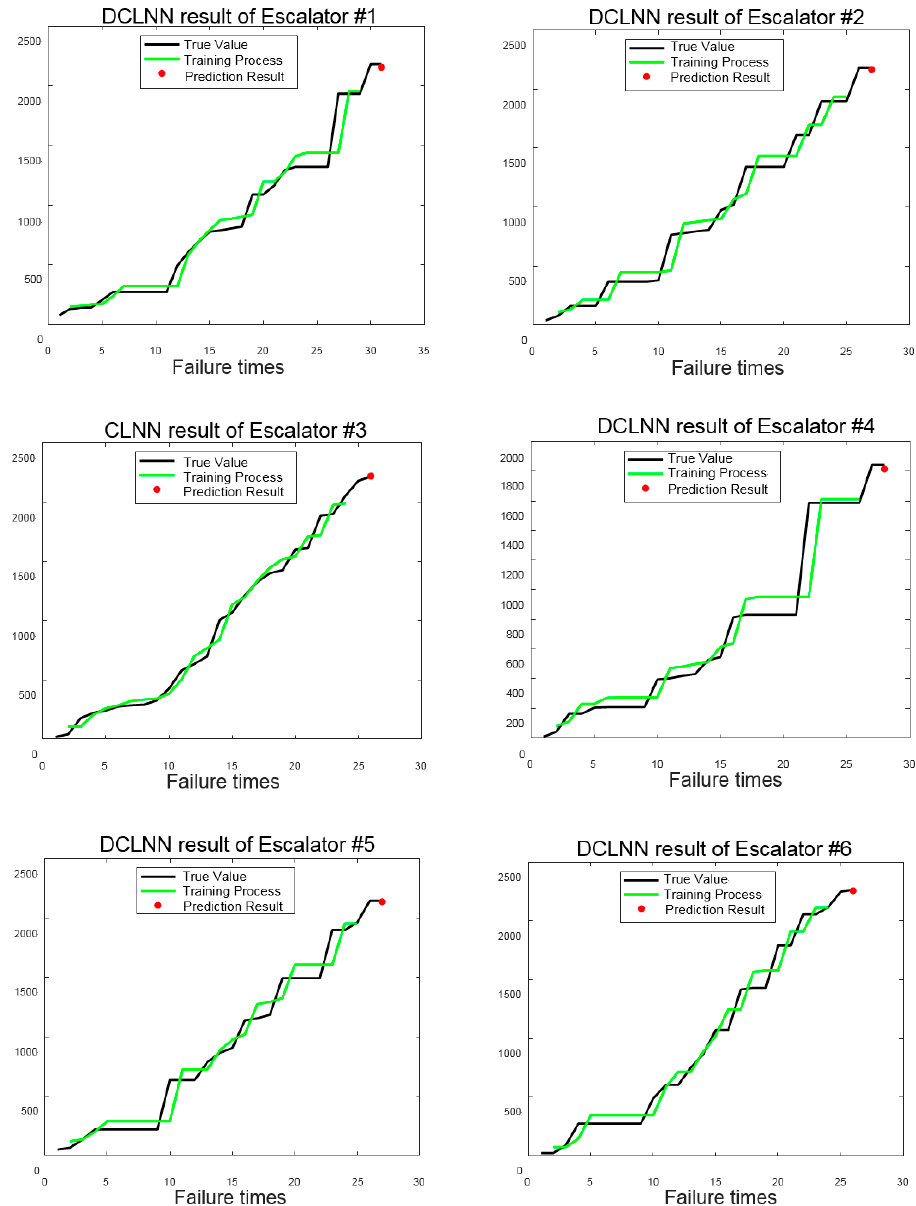
Figure 15. Training process and prediction using DCLNN.